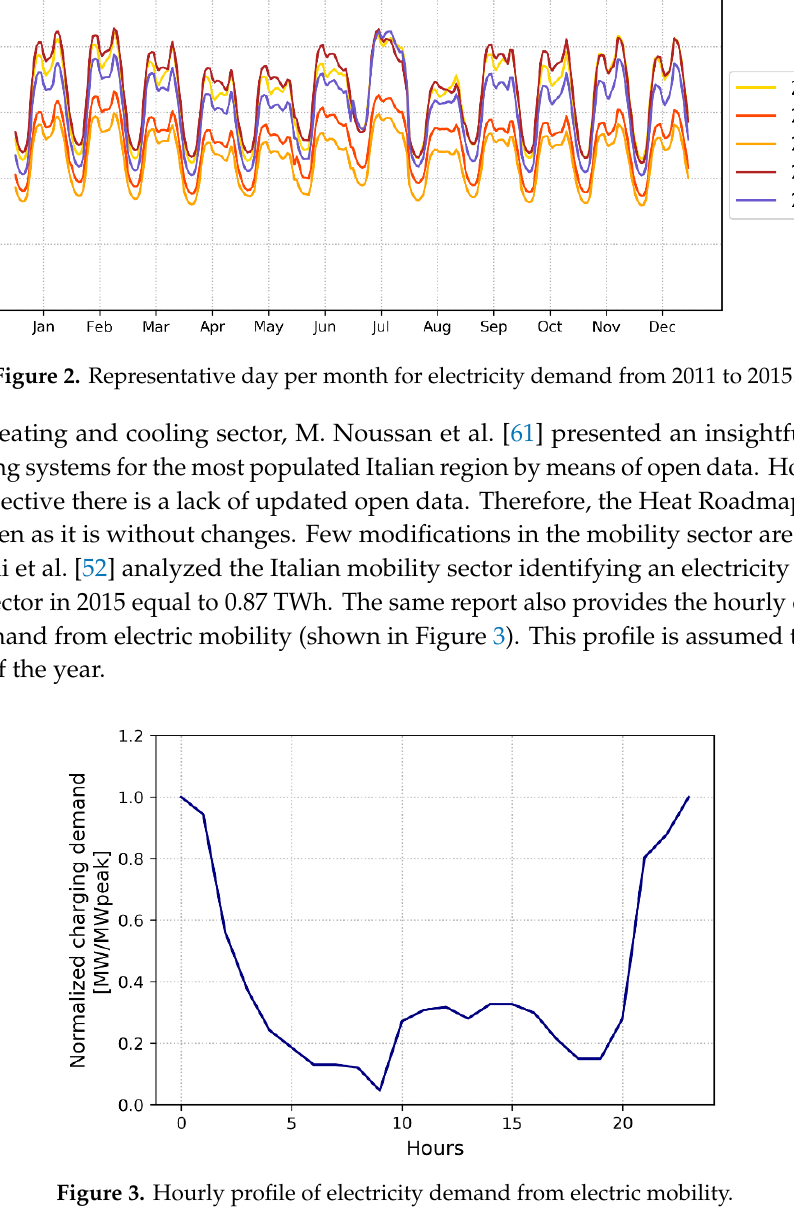
Figure 4. Comparison of annual CO 2 emissions between the value obtained through simulation in the Baseline 2015 and those given by other different sources: UNFCCC [63], OECD [64], BP [65], IEA [62] and ISPRA [66]. 3.2. PNIEC 2030 Scenario The second step is the definition of the EnergyPLAN input file for the Italian integrated energy and climate action plan [3]. All the input values are taken from the Italian integrated energy and climate